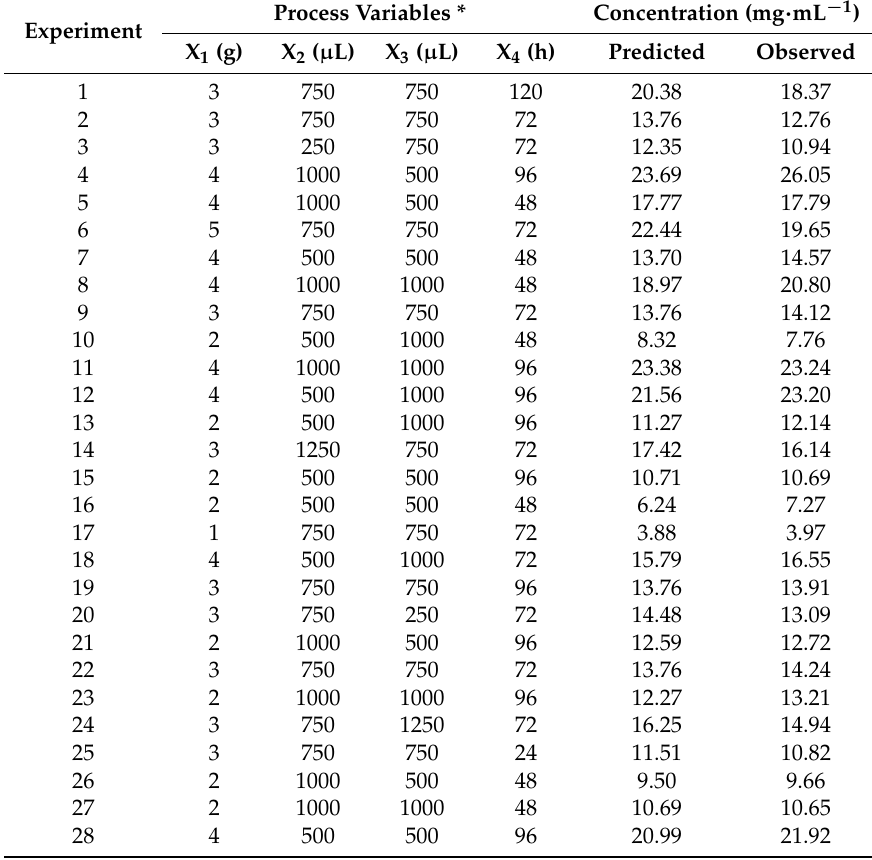
Experiment conditions as determined by STATGraphic Centurion XV software ® (STATGraphics Centurion, Warrenton, VA, USA). Also included are predicted and observed reducing sugar values for each